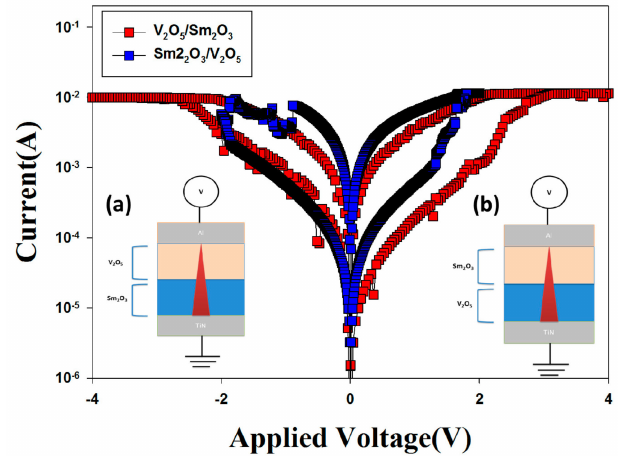
Figure 5. The resistive switching characteristics of the Al / V 2 O 5 / Sm 2 O 3 / TiN / SiO 2 / Si and Al / Sm 2 O 3 / V 2 O 5 / TiN / SiO 2 / Si memory